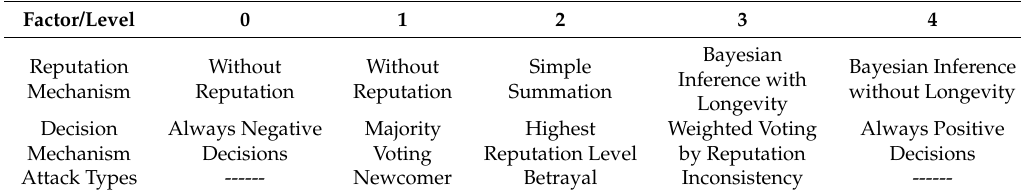
Table 2. Factors and levels of the Restricted Scenario.